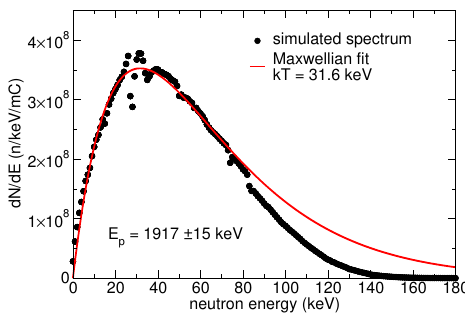
Figure 3. A simulated neutron spectrum impinging on the Zr target for the Exp II irradiation. Figure adapted from